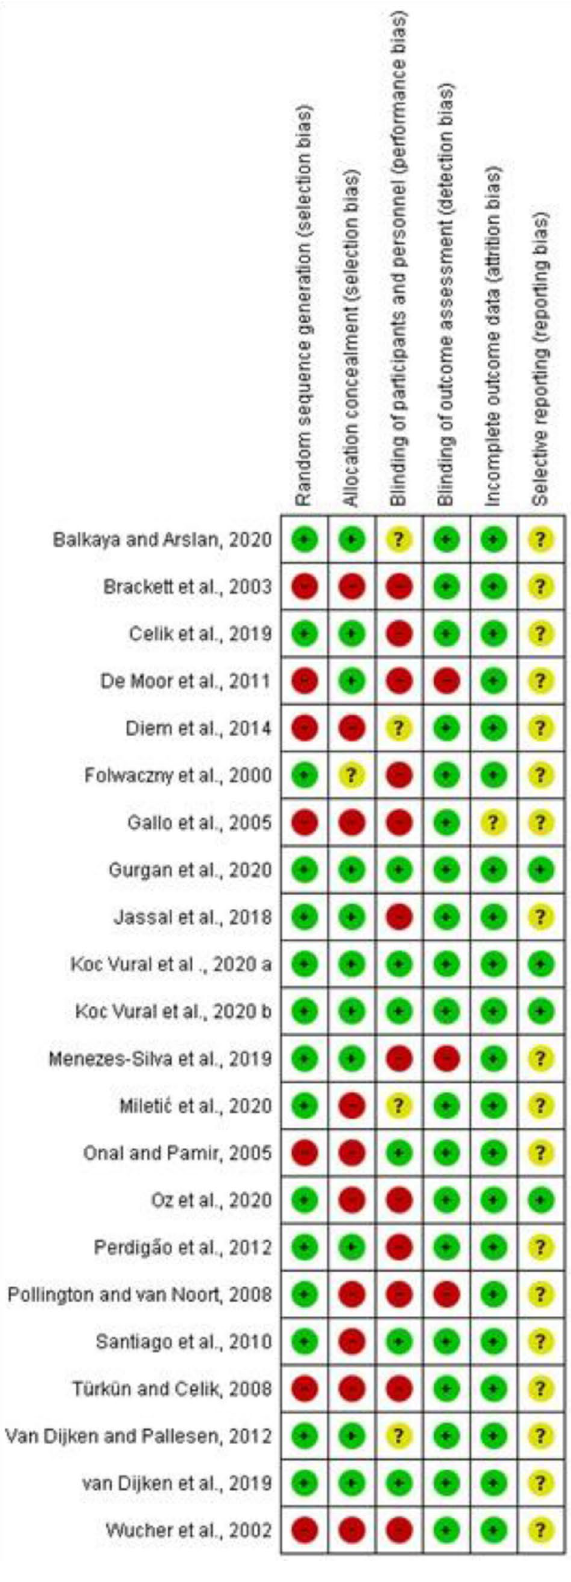
Figure 2. Risk of bias summary: authors’ judgments about each risk of bias item for each included study. Filled Green circle Low ROB Filled Red circle High ROB Filled Yellow Circle Unclear